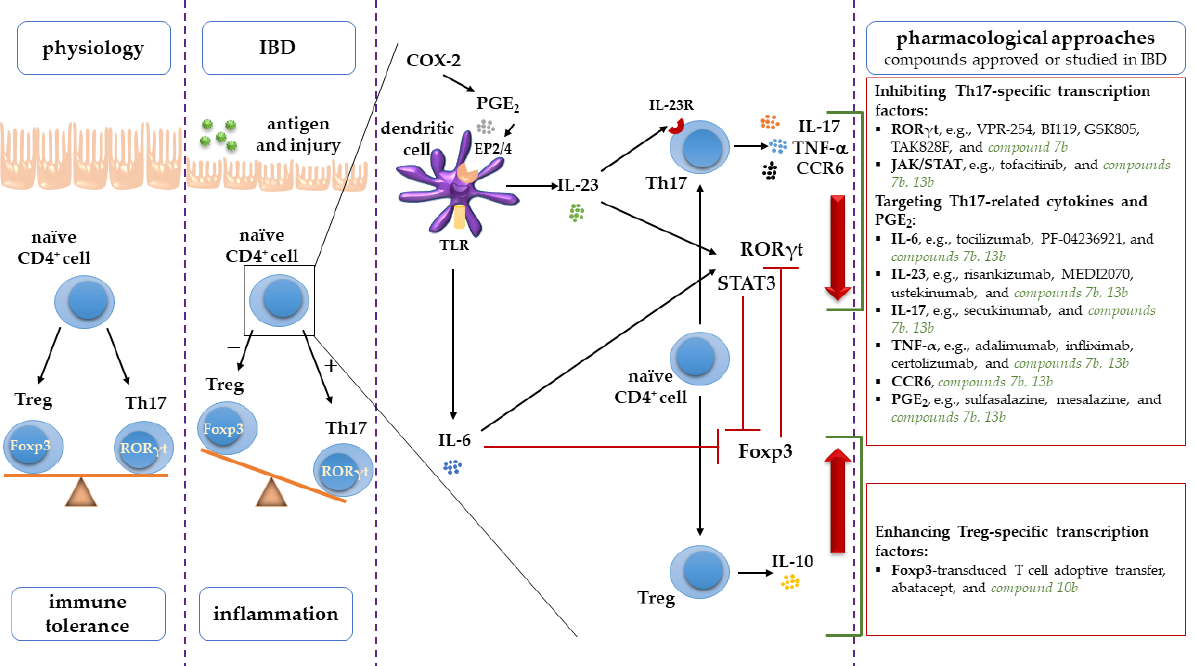
Figure 10. Th17/Treg axis, essential for intestinal immune homeostasis when balanced, crucial in IBD pathogenesis when dysregulated, reciprocally interconnected regarding Th17 and Treg cells development, and new pharmacological target in IBD [3,12,13,16,17,39,43–52,60,65]. Abbreviations: COX-2, cyclooxygenase-2; CCR6, C-C chemokine receptor 6; EP2/4, prostaglandin E receptor 2 and 4; Foxp3, forkhead box protein 3; IBD, inflammatory bowel disease; IL, interleukin; IL-23R, IL-23 receptor; PGE 2 , prostaglandin E 2; ROR, retinoic acid-related orphan receptor γ t; STAT3, signal transducer and activator of transcription 3, Th17, T helper 17 cell, Treg, regulatory T cell; TLR, Toll-like receptor; TNF- α , tumor necrosis factor α